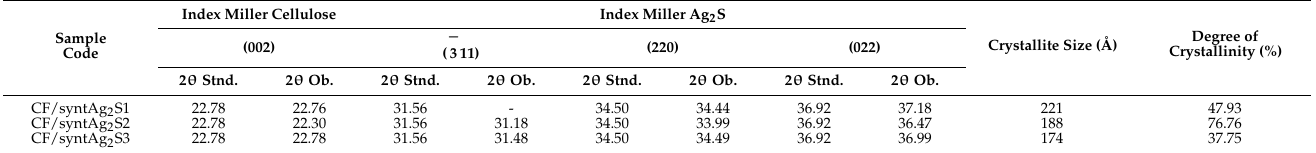
Table 4. Phase identification and crystallinity of the CF/syntAg 2 S sample.